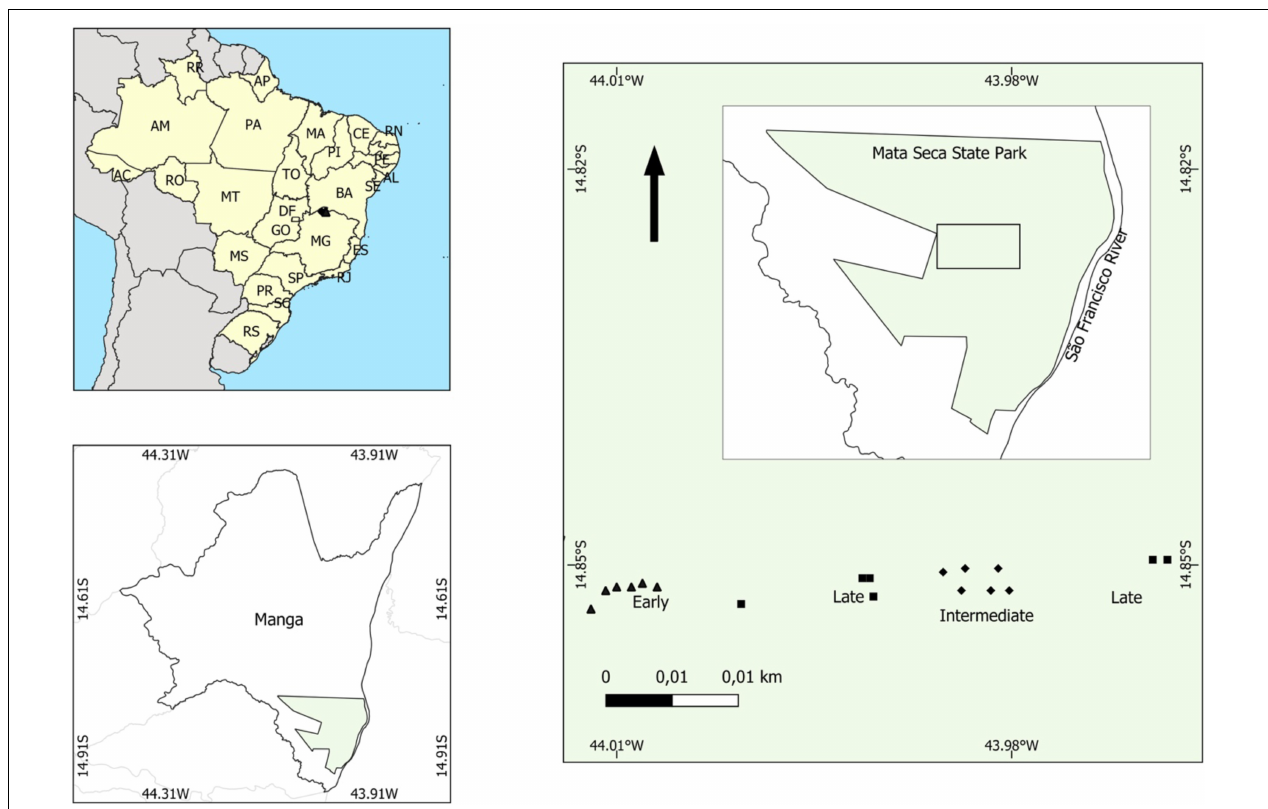
FIGURE 1 | Location of the study site, in the Mata Seca State Park, north of Minas Gerais state in Brazil. The spatial distribution of the 18 plots in early, intermediate and late successional stages is also